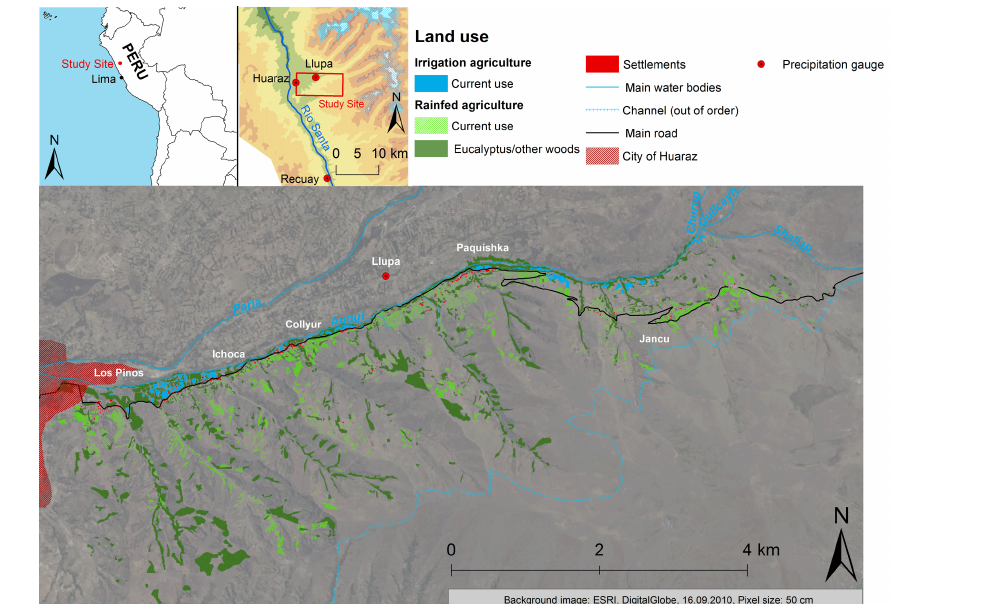
Figure 1. The study site (Cuenca Auqui) within the Rio Santa valley in Northwestern Peru.